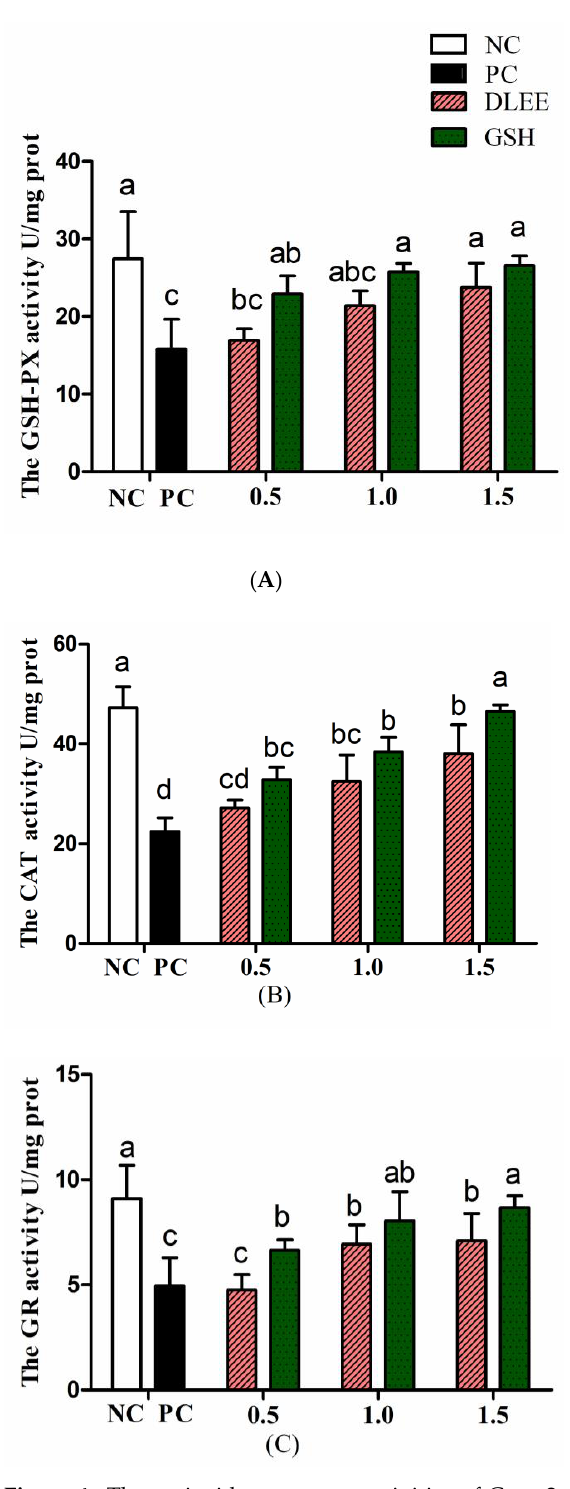
Figure 4. The antioxidant enzyme activities of Caco-2 cells. ( A ) GSH-PX, ( B ) CAT, ( C ) GR. NC, negative control group without any treatments; PC, H 2 O 2 -induced positive control group (1 mM, 2 h); different concentrations of DLEE and GSH (0.5, 1.0, or 1.5 mg/mL) were added for 2 h along with H 2 O 2 . Data are presented as the means ± SD ( n = 6) and the differences between groups were compared by Tukey’s Multiple Comparison Test in a One-way analysis. The same letters represent no differences and different letters denote a significant difference between groups ( p <